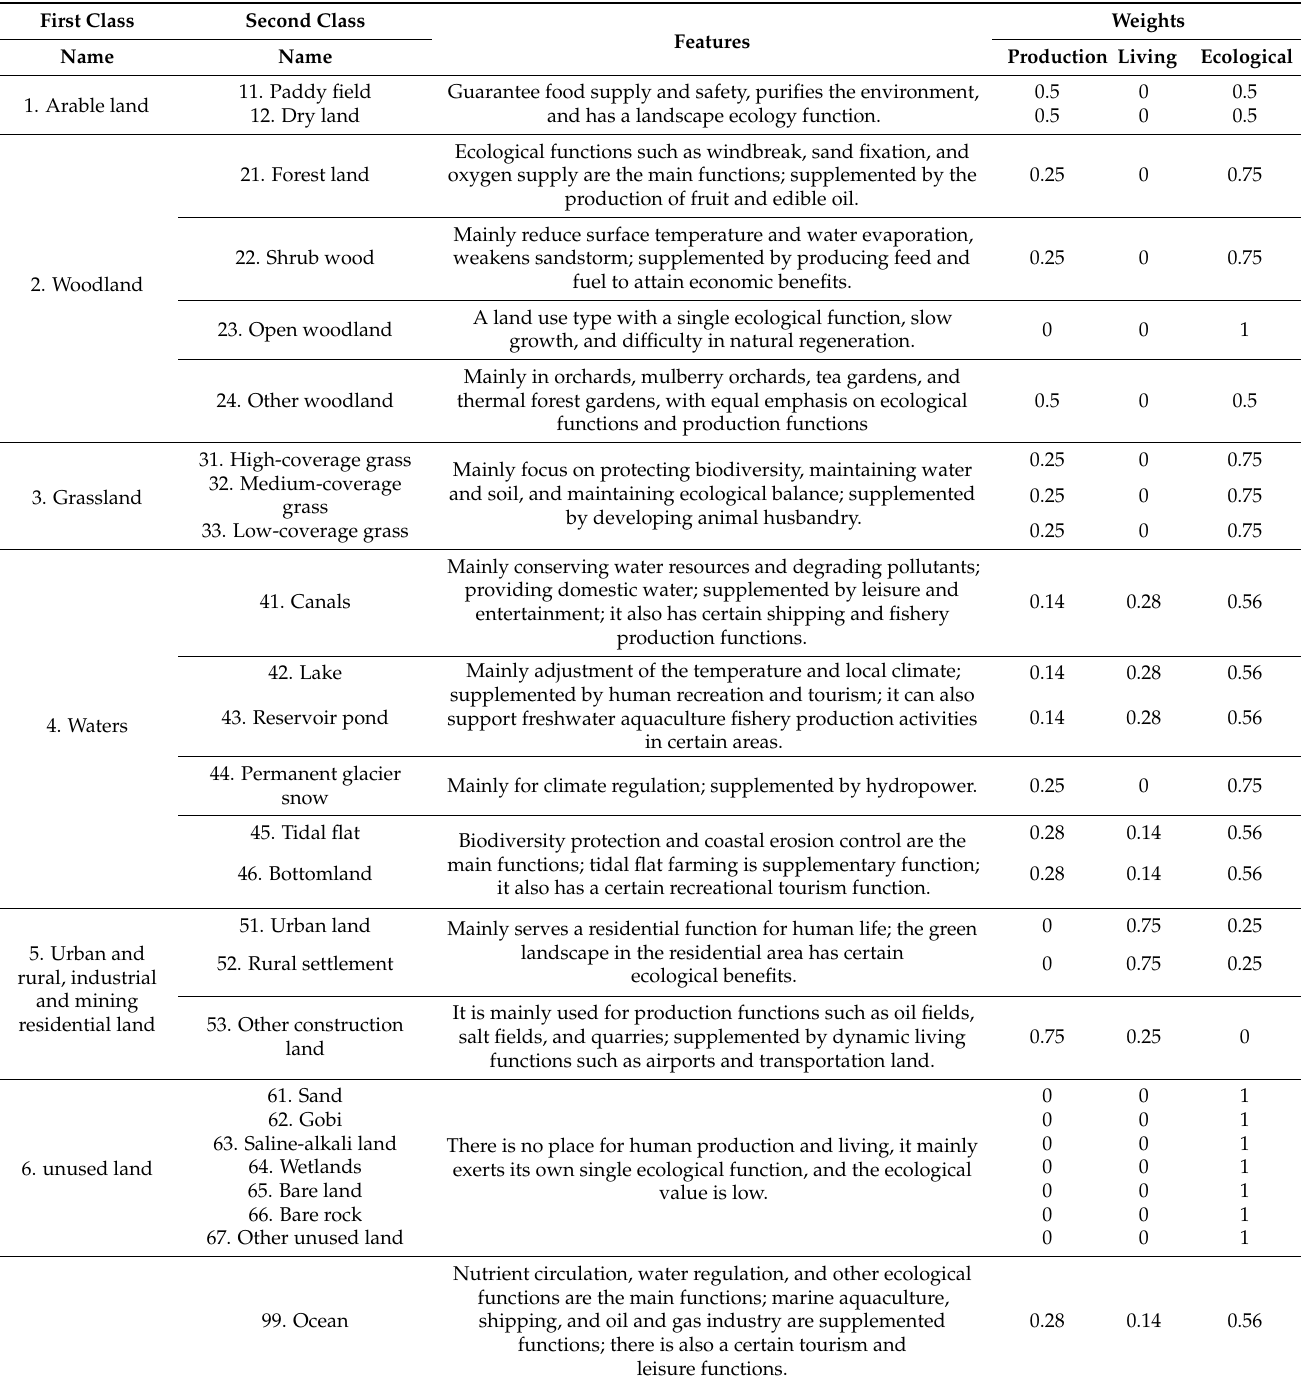
Table 1. Production-ecological-living space multi-function weighting